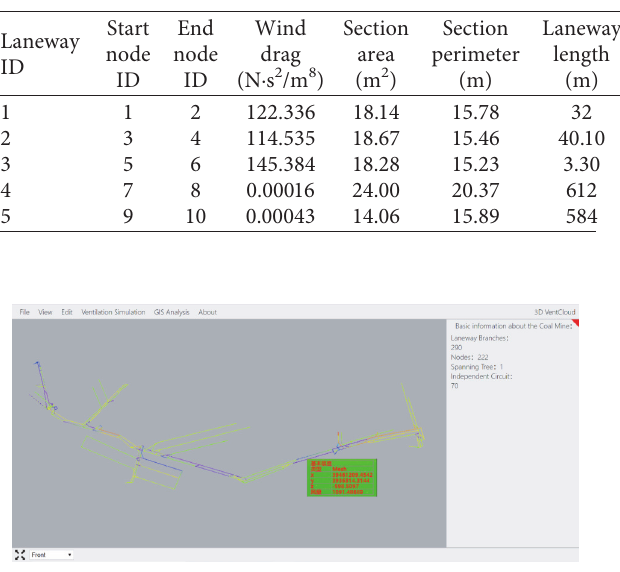
Figure 8: The 3D laneway network model of Xinqiao coal Table 5: Some of the ventilation attribute data for Xinqiao coal mine laneway.